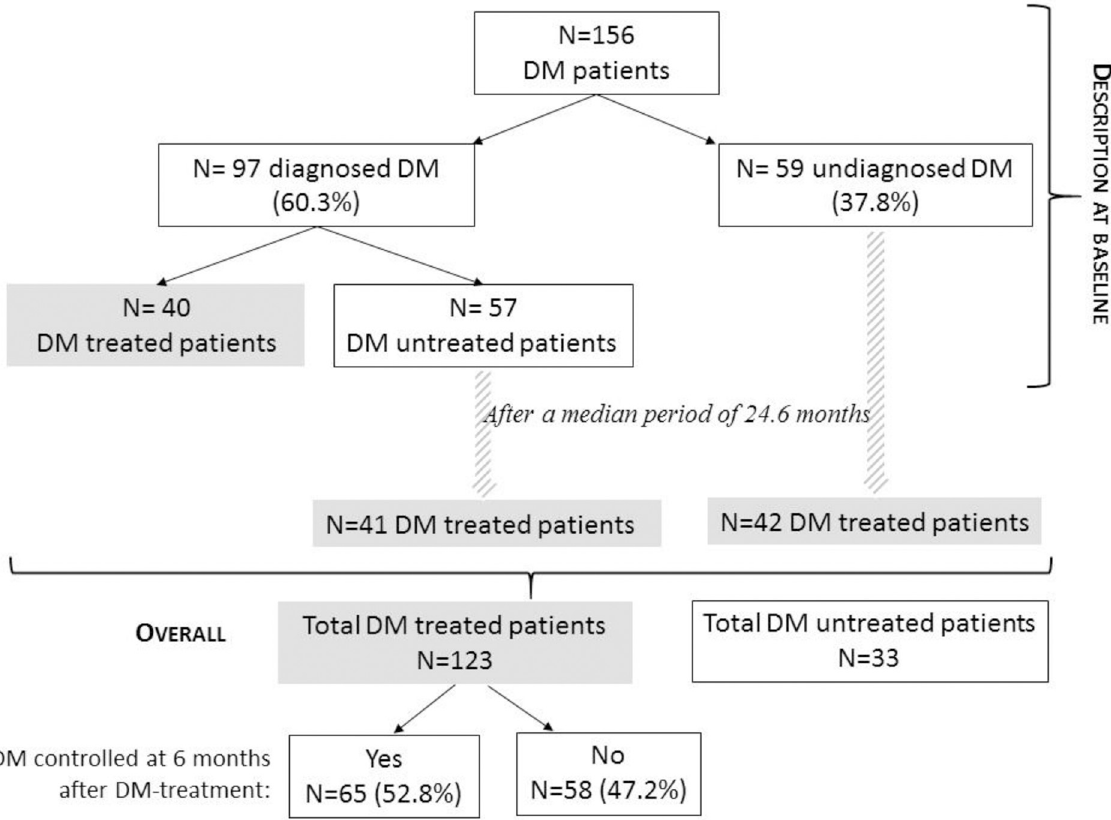
Fig 2. The cascade from diagnosis to DM control. DM treated: Treated by hypoglycemic agents; DM untreated: Without pharmaceutical hypoglycemic treatment.